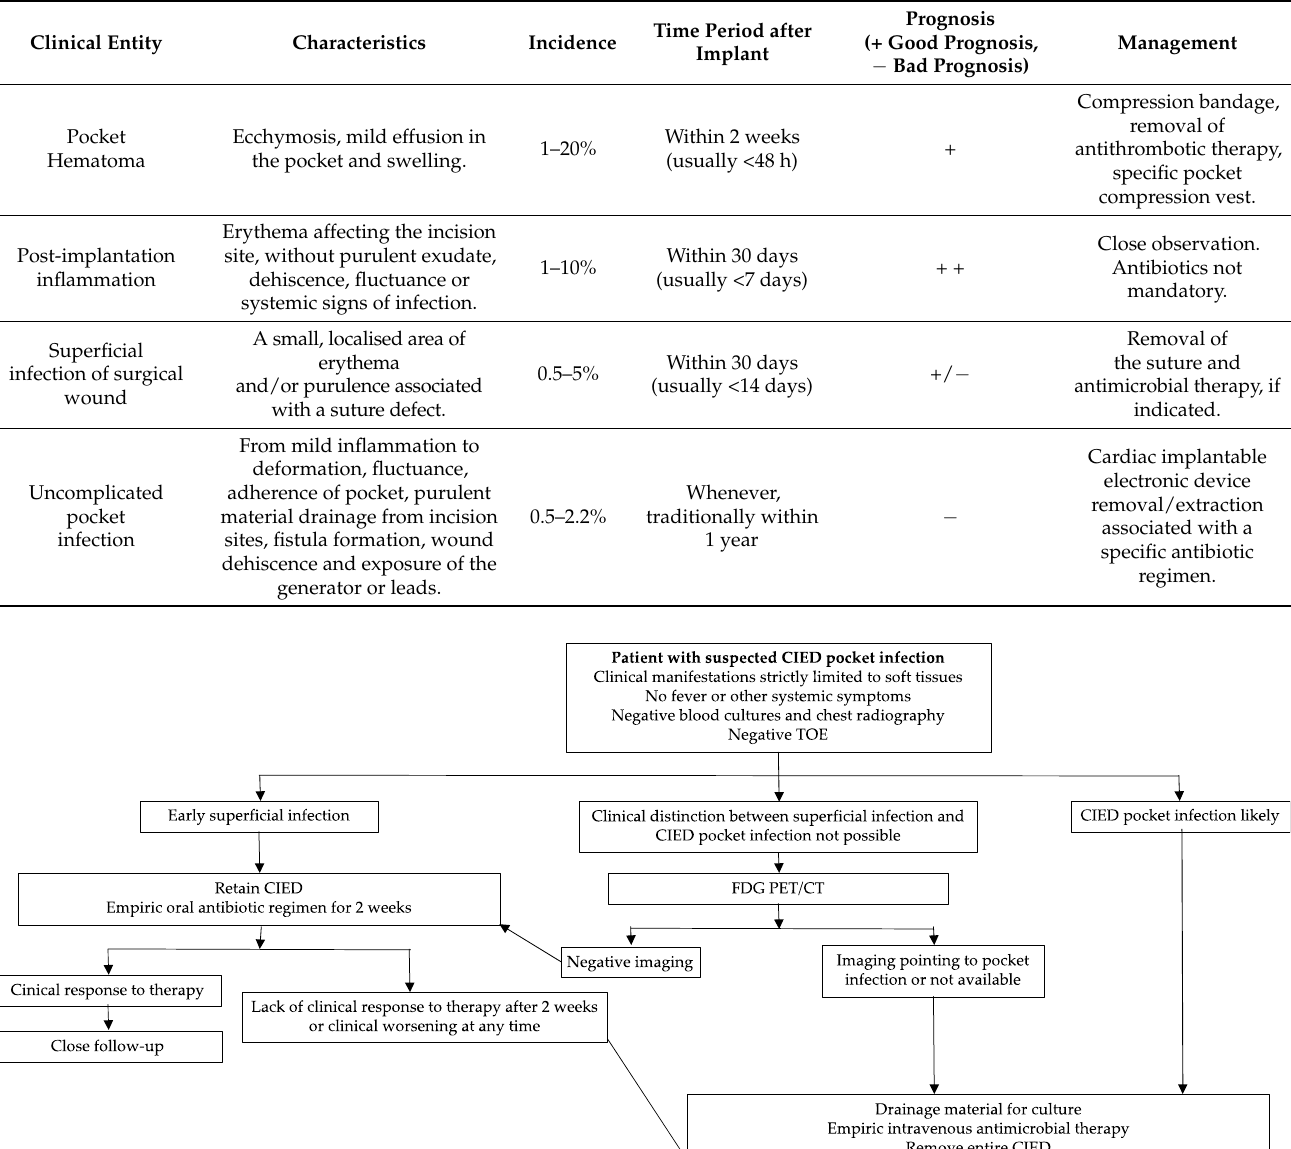
Table 1. Differential diagnosis among cardiac implantable electronic device pocket complications.